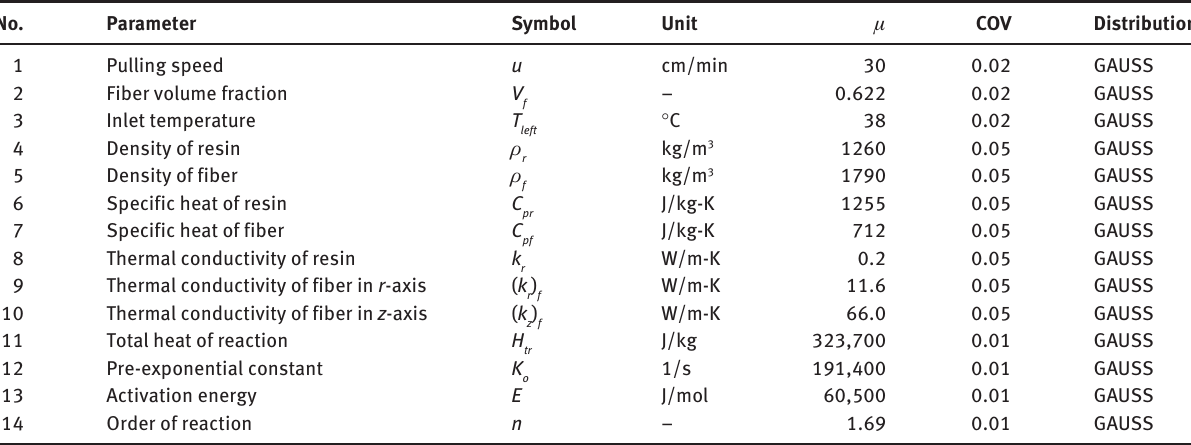
Table 1 Statistical characteristics of the RIPs for the pultrusion process.